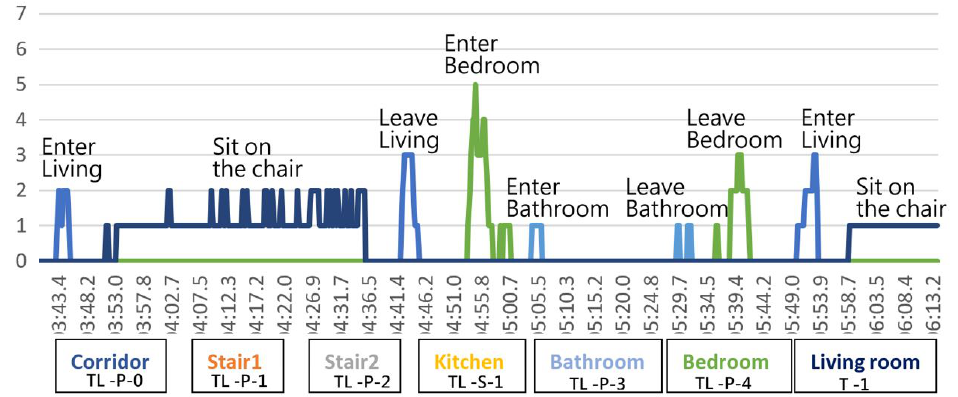
Figure 7. Behavior classification of the accumulated data (10 December